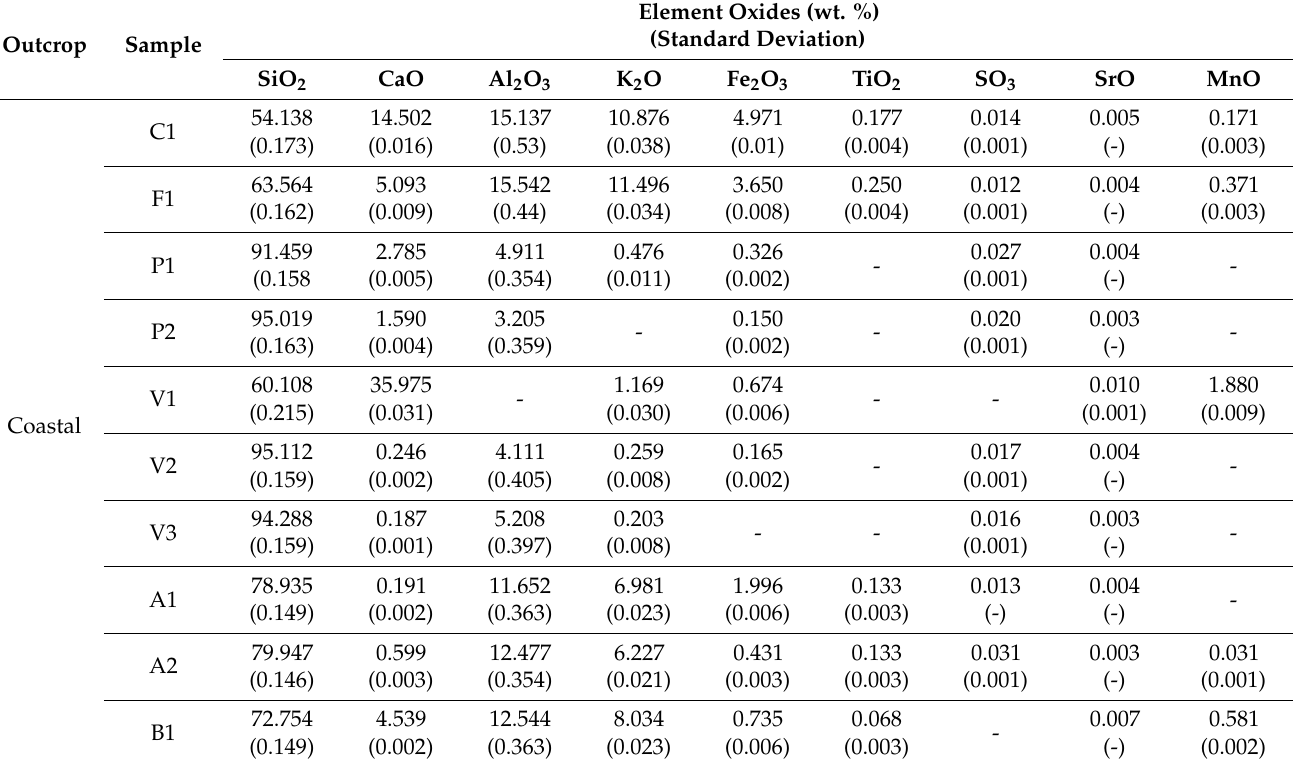
Table 3. Percentages of the element oxides analyzed with ED-XRF of the outcrops